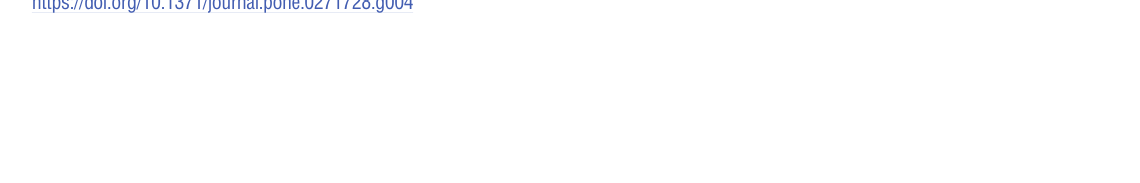
PLOS ONE | https://doi.org/10.1371/journal.pone.0271728 August 1,